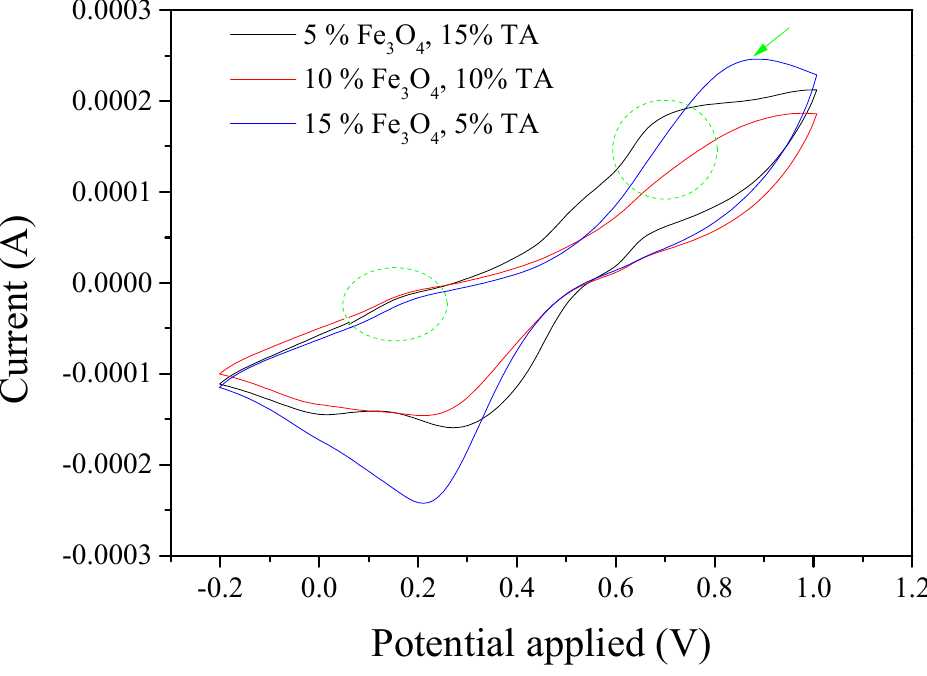
Figure 10. Cyclic voltammetry measurement for S-SEBS polymer with various amounts of TA and Fe 3 O 4 nanoparticles. (Note: all % in the figure is wt.%.)